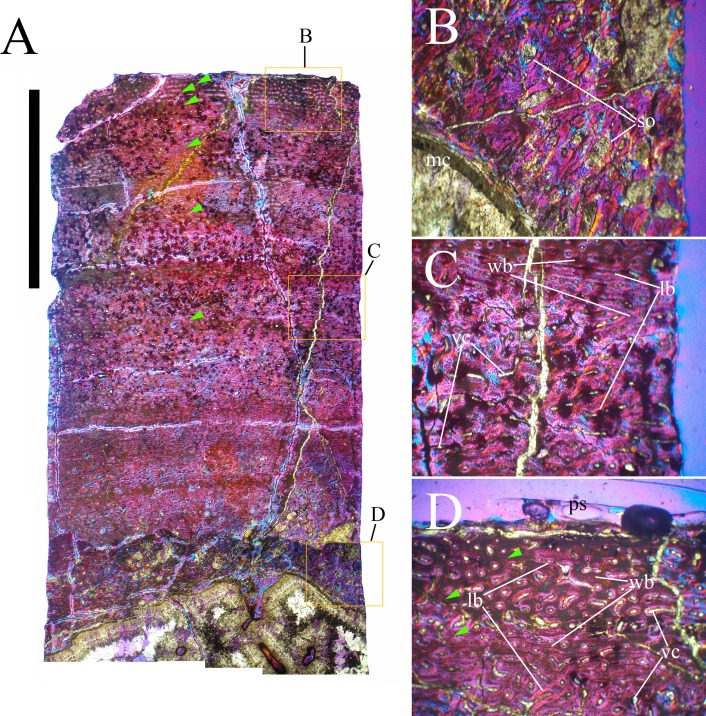
MSNVE 3714, right tibia, thin section.Panoramic view under lambda filter (the outer surface of the bone is at the top of the figure) (A); gradual transition between the compacta and the medullary cavity made of CCB and erosional cavities (B); detail of the deeper cortex, showing zonation of the primary bone, irregular vascularization and fibrolamellar bone (C); detail of the outermost cortex showing the absence of an EFS (D); note the remodeling in the inner compacta. Abbreviations: lb, lamellar bone; mc, medullary cavity; ps, periosteal surface; so, secondary osteons; vc, vascular canals; wb, woven bone. Green arrows point to the LAGS. Scale bars equal 10 mm in A and 1 mm in B–D.